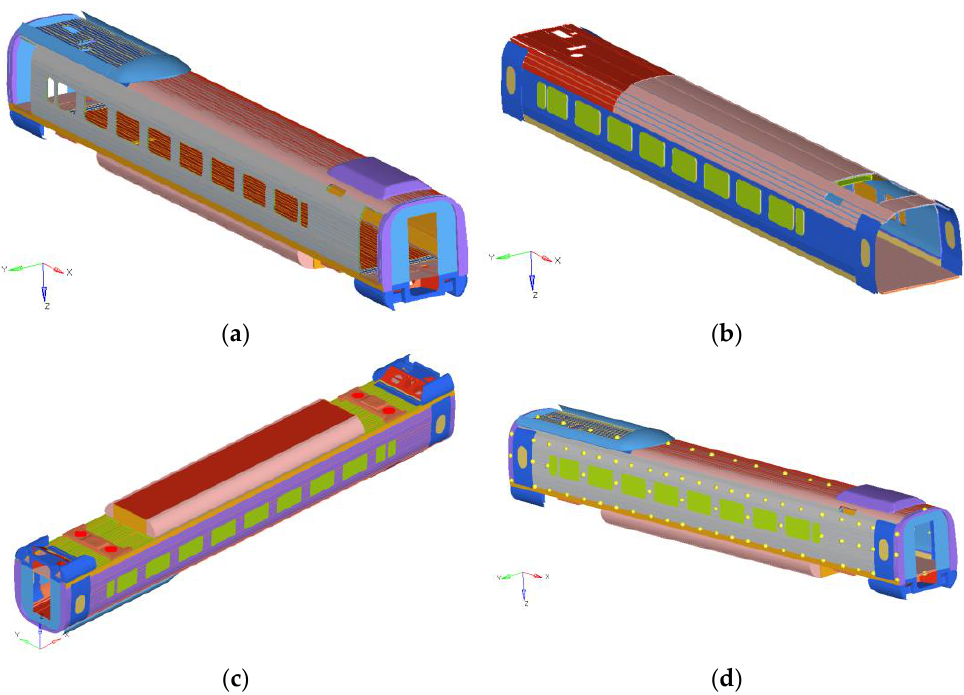
Figure 4. FE model of the carriage. ( a ) FE model of BIW; ( b ) trim parts; ( c ) full-trimmed carriage assembly; ( d ) main node of the carriage substructure.